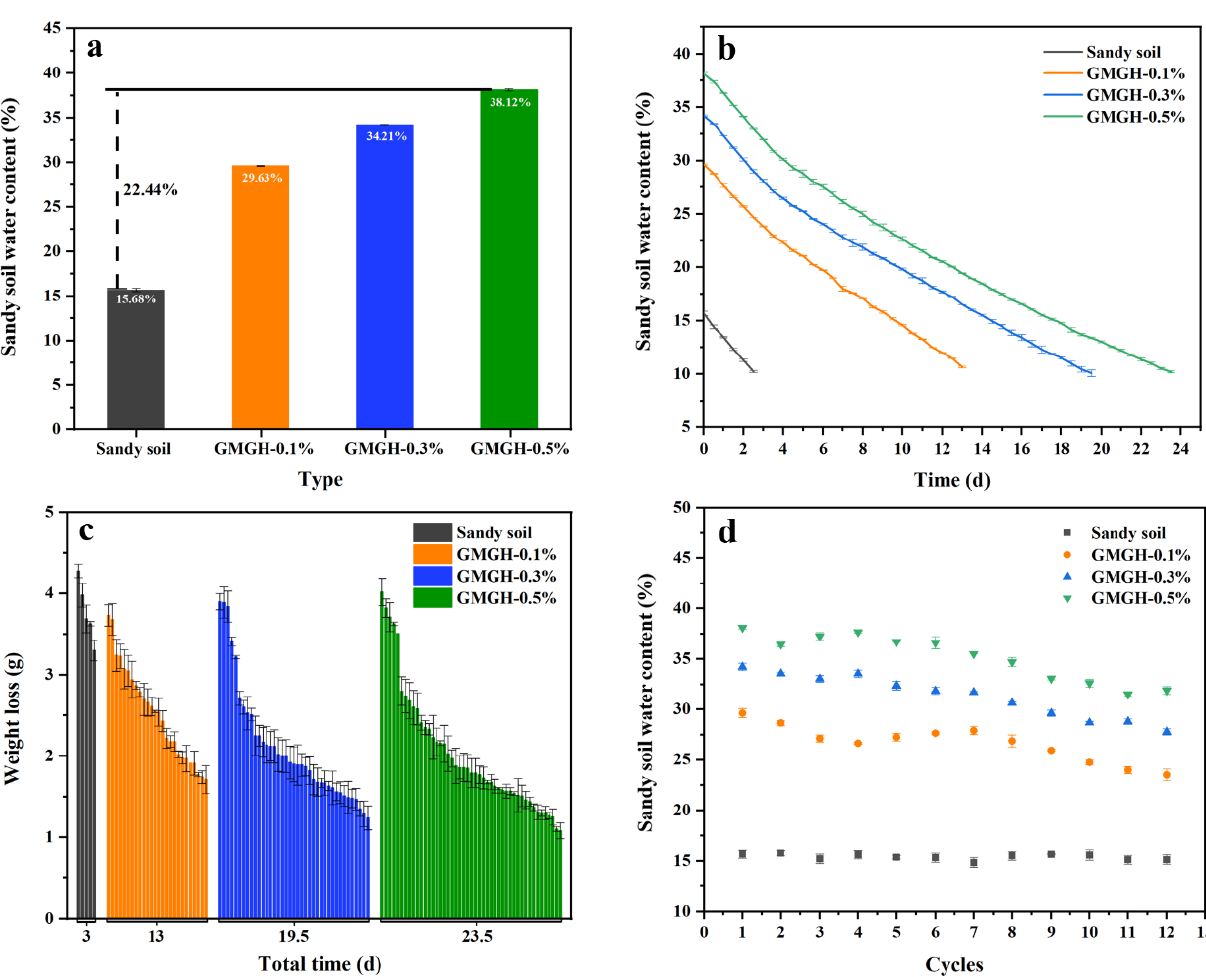
Figure 5. ( a ) The maximum SI of the sandy soil and soil–GMGH in tap water; ( b ) the relationship between the SI and time of soil–GMGH in the artificial climate box; ( c ) weight changes in the soil and soil–GMGH in each period (12 h); ( d ) repeated water absorption and the water retention index of soil and soil – GMGH.